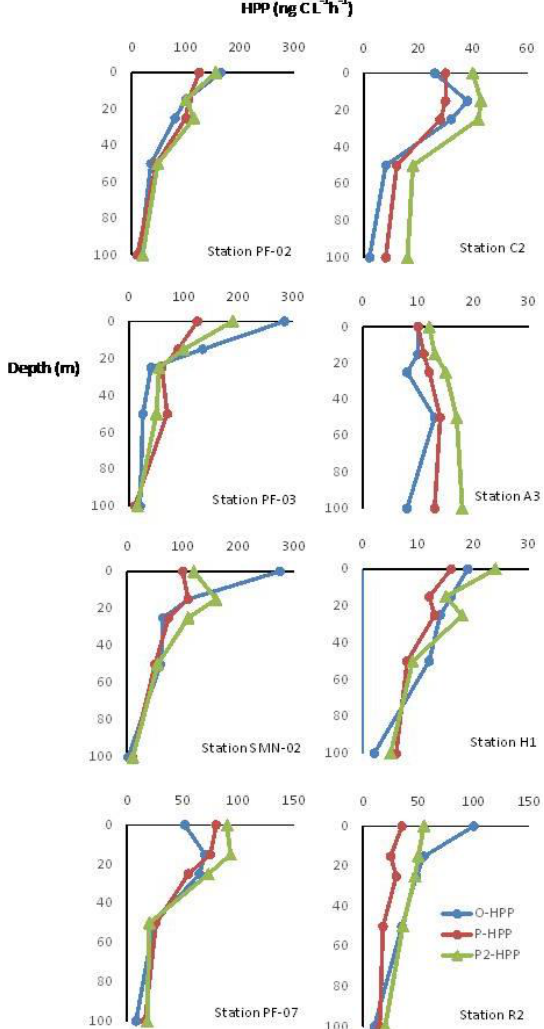
Figure 3. Terra Nova Bay (TNB, column on the left) and Victoria Land (VLT, column on the right) surveys. Vertical distribution along the water column of the observed (O-HPP) values of Heterotrophic prokaryotic production (HPP) and the predicted HPP values (P-HPP) from the total dataset and from the simultaneous use of two different regression equations developed according to both datasets ( ≤ 50 and >50 nM h − 1 ) of Leucine AminoPeptidase (LAP) concentrations (P2-HPP).